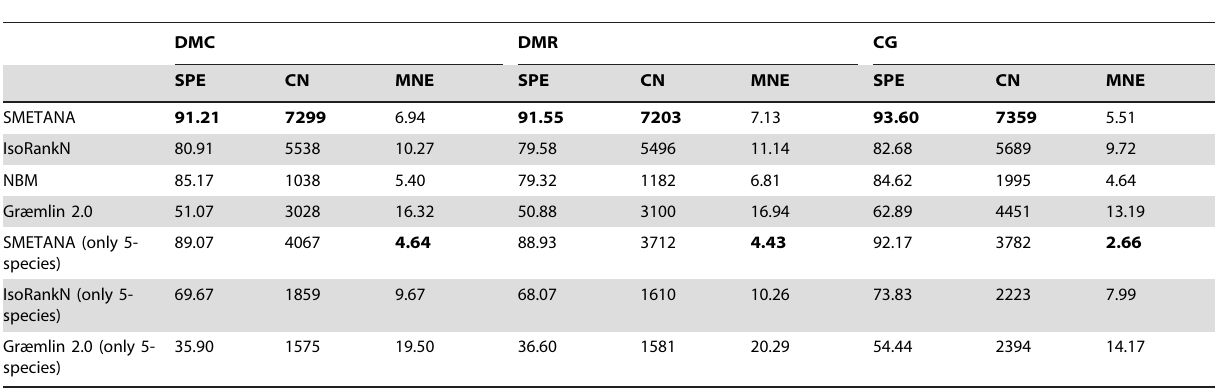
Table 2. Performance of different algorithms for 5-way network alignment.